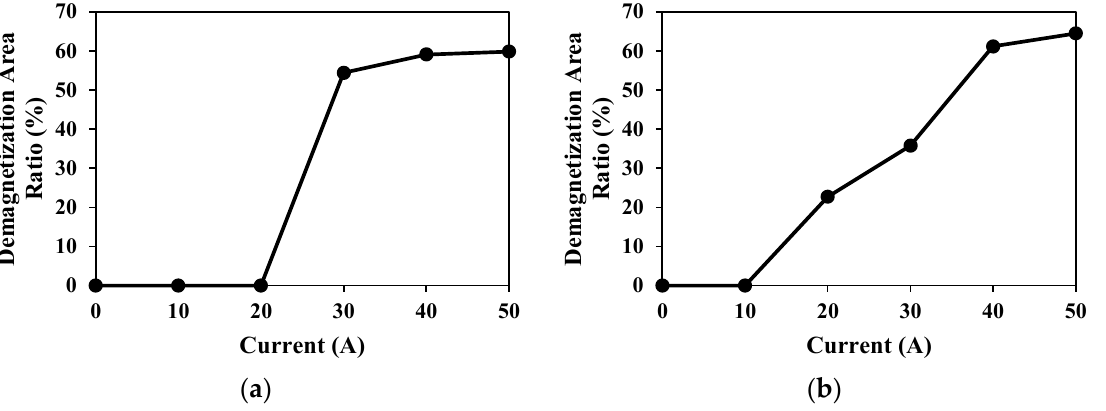
Figure 34. Torque characteristics of 12s10p-PSCPPM machine. ( a ) Average torque and torque ripple. ( b ) Peak to peak value of torque components. ( c ) Overall torque ripple spectra. ( d ) Phases of dominant 6th order torque harmonics.